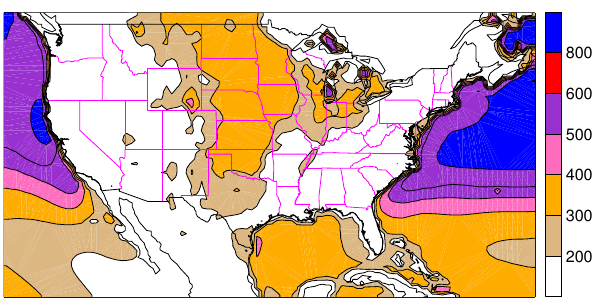
Fig. 10. Geographical variation of the mean WPD at 80m (W m − 2 ).